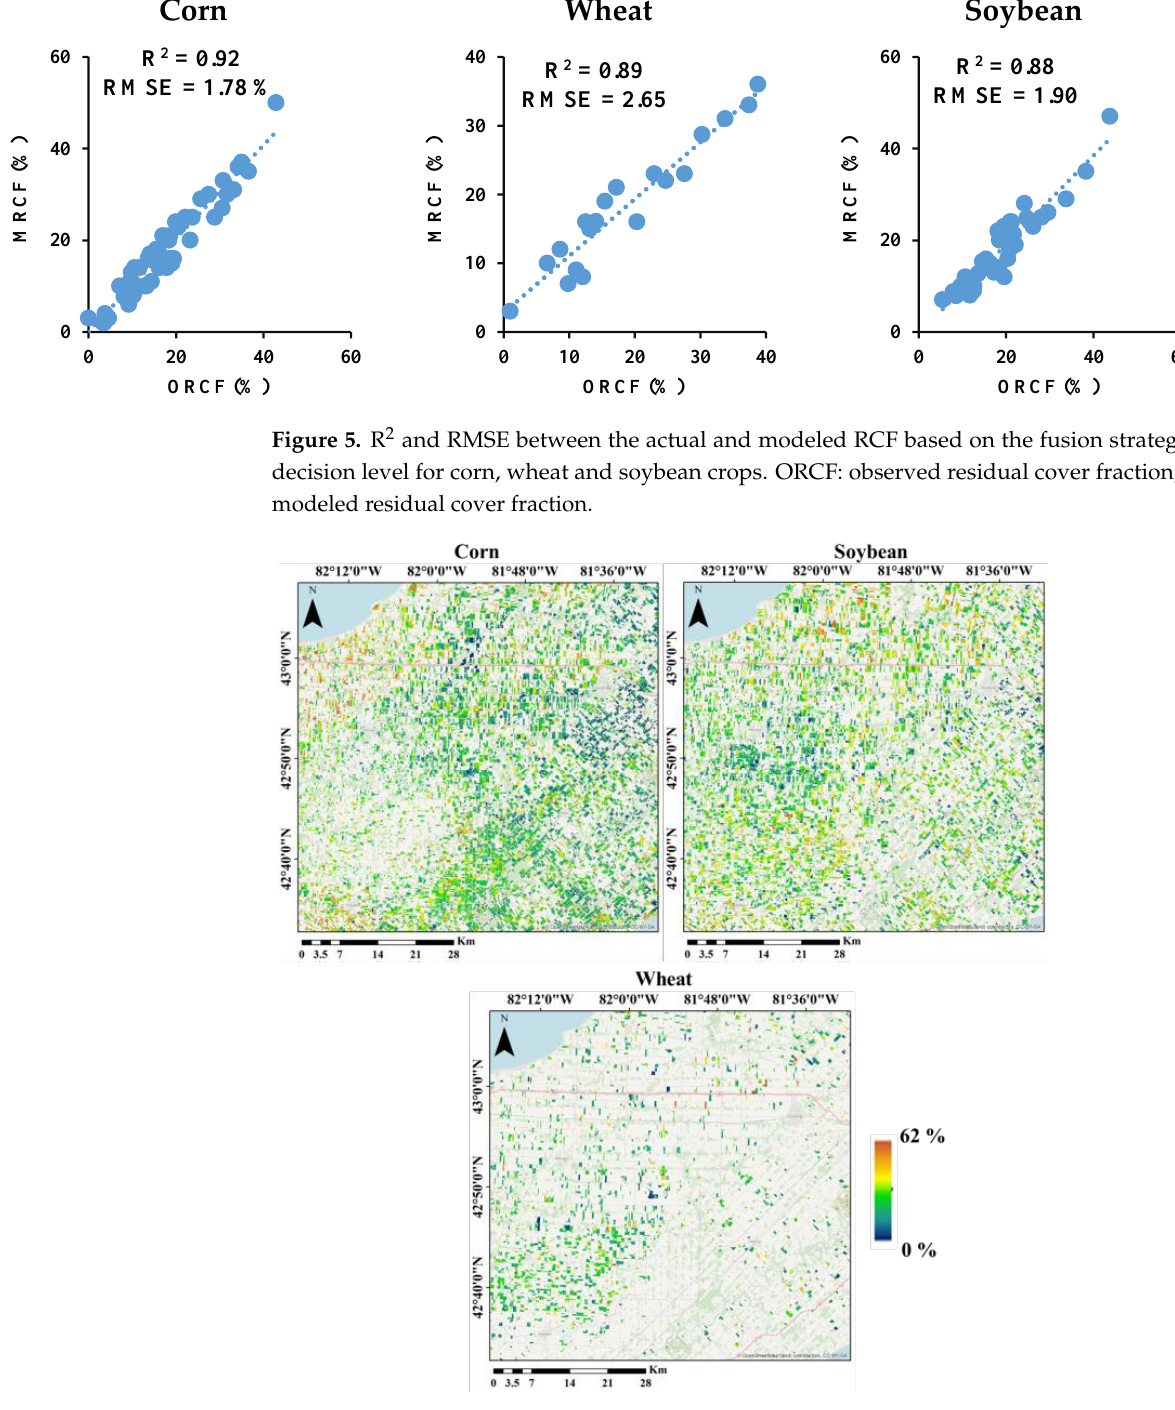
Figure 6. RCF maps for different land crop in the study area. The mean RCF for corn, wheat and soybean crops in the study area were 18.2%, 19.39% and 17.7%, respectively (Figure 7). RCF was higher in wheat fields than in corn and soybean fields. The values of the standard deviation (Sd) of the RCF for corn, wheat and soybean fields in the study area were 8.3%, 10.23% and 7.4%, respectively. The highest and lowest variation of RCF in this study area was related to wheat and soybean crops. The range of variation in the RCF amount for corn fields as greater than wheat and corn